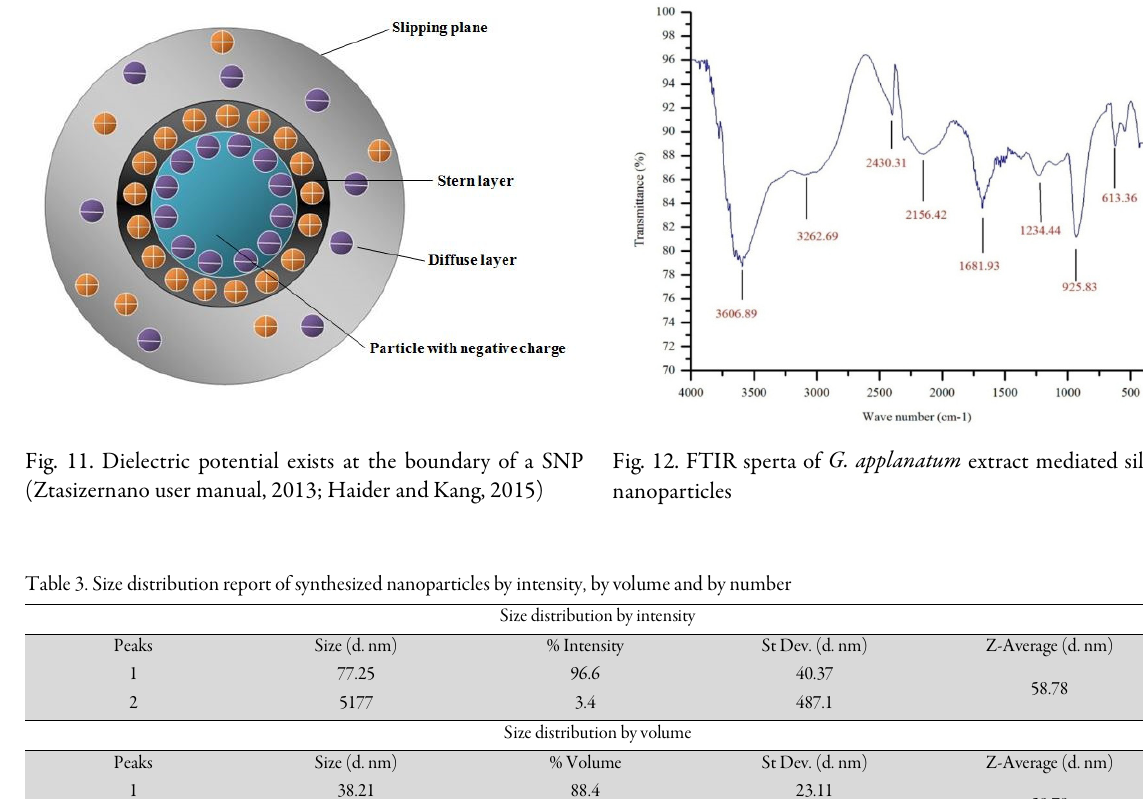
Table 4. Behavioural symptoms of rats treated with vehicle and SNPs 2000 mg/kg. N=nontoxic effect, I=increase, NF=not found Groups of rats Group-A